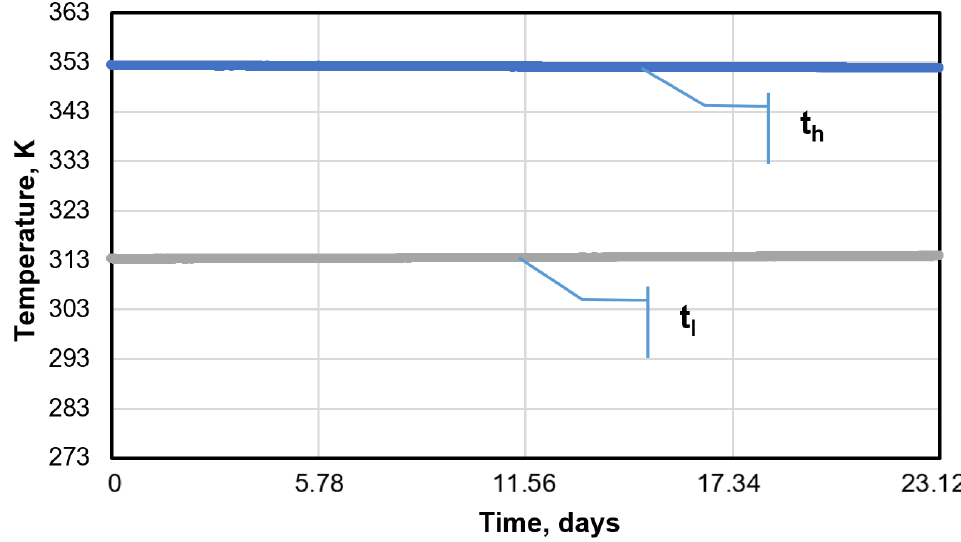
Figure 6. Temperature changes through the thermocline during simulation.